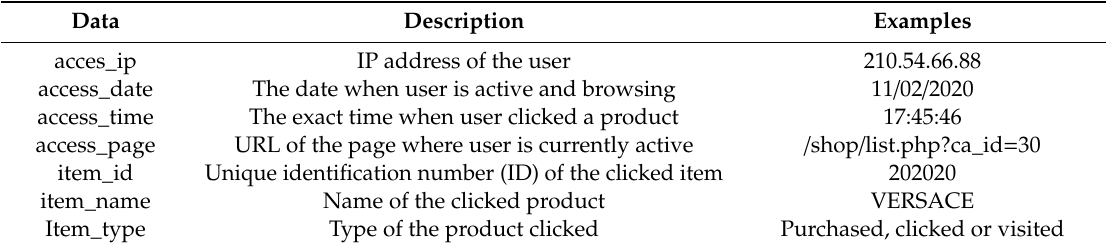
Table 1. Data Description and